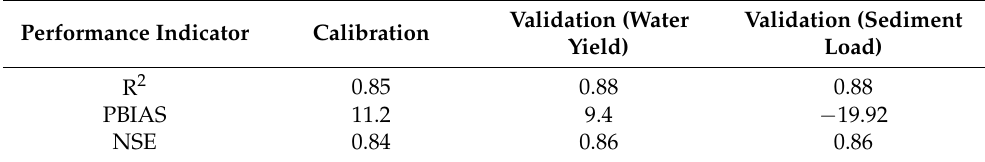
Table 3. Calibration and validation performance results.